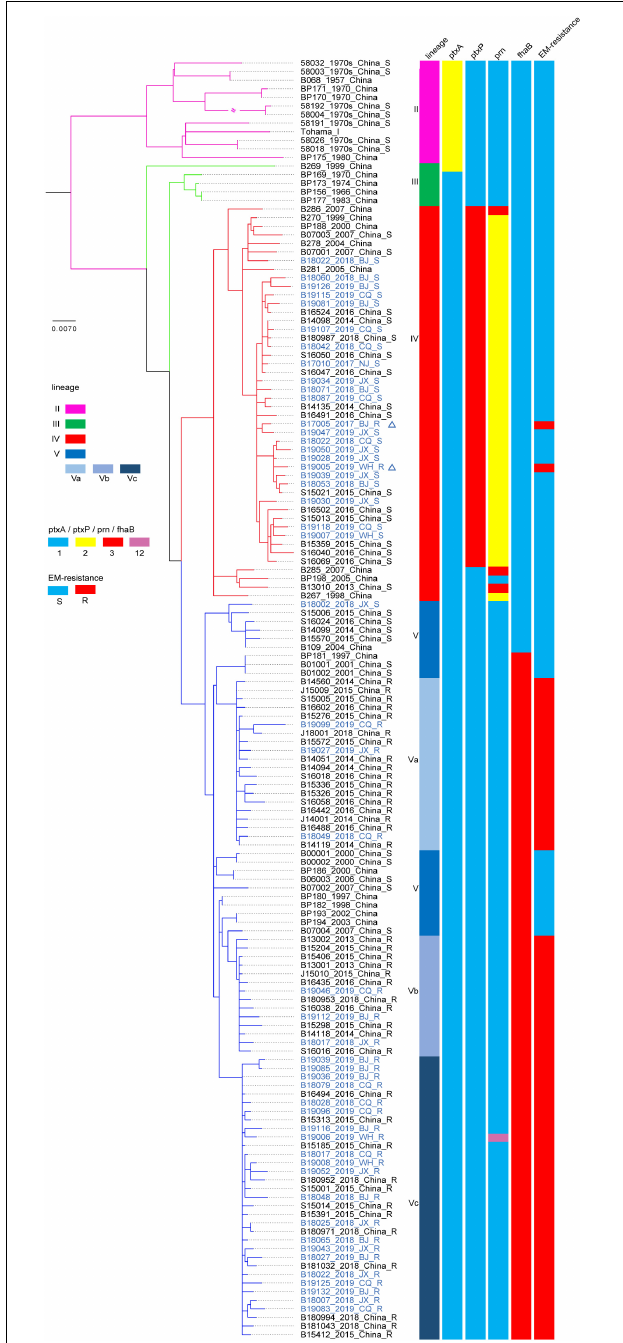
FIGURE 2 | Maximum clade credibility phylogenetic tree for Chinese Bordetella pertussis isolates in the present and previous studies based on whole-genome s ingle-nucleotide polymorphism (SNPs). Maximum clade credibility phylogenetic tree for 148 Chinese B. pertussis isolates. The leaves are marked as “sample ID_ isolated year_isolated area_erythromycin resistance.” The leaves representing the strains in the present study are colored blue. The two leaves marked by triangles represent the location of two ptxP3 -ER (erythromycin-resistance) strains in the present study. Vertical bars on the right display the lineage, ptxA , ptxP , prn , fhaB allele type, and ER for each strain or sub-lineage. The legend is on the left side of the